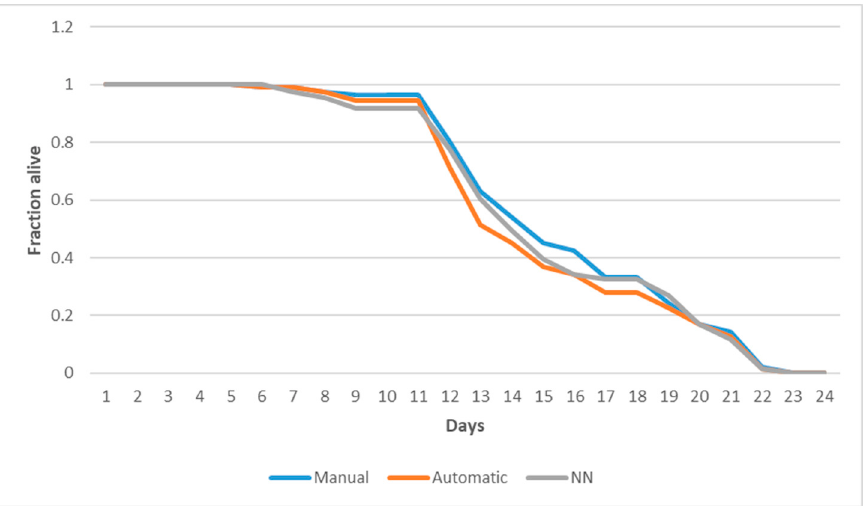
Figure 8. Comparison of manual counting (blue curve), automatic counting traditional method (orange curve), and counting with the proposed method (grey curve). The horizontal axis shows the days of the experiment, and the vertical axis shows the proportion of live C. elegans . Capture was performed until day 21, and the remaining days were approximated using a Kaplan–Meier estimator.